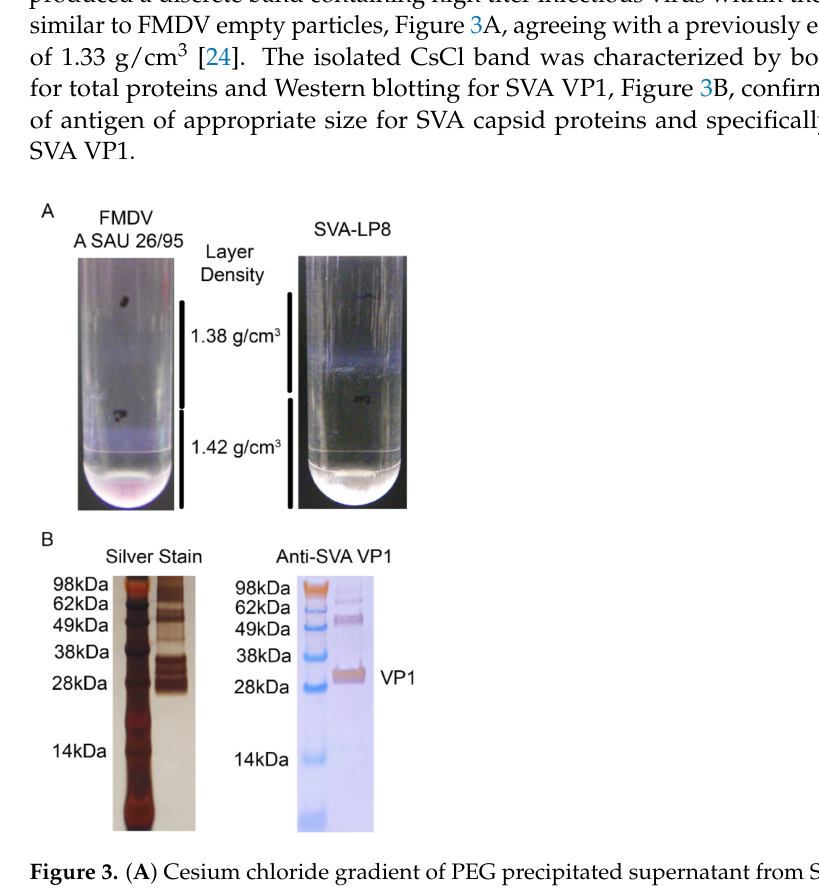
Figure 3. ( A ) Cesium chloride gradient of PEG precipitated supernatant from SVA-LP8 inoculated LF-BK α V β 6 cells produced a discrete white band just above the 1.42 g/cm 3 density. ( B ) The band harvested from the gradient demonstrated bands of the expected size for individual viral proteins and capsid subunits when run on a denaturing gel and stained. Polyclonal anti-SVA VP1 antibody was reactive with individual VP1 as well as VP1 containing capsid